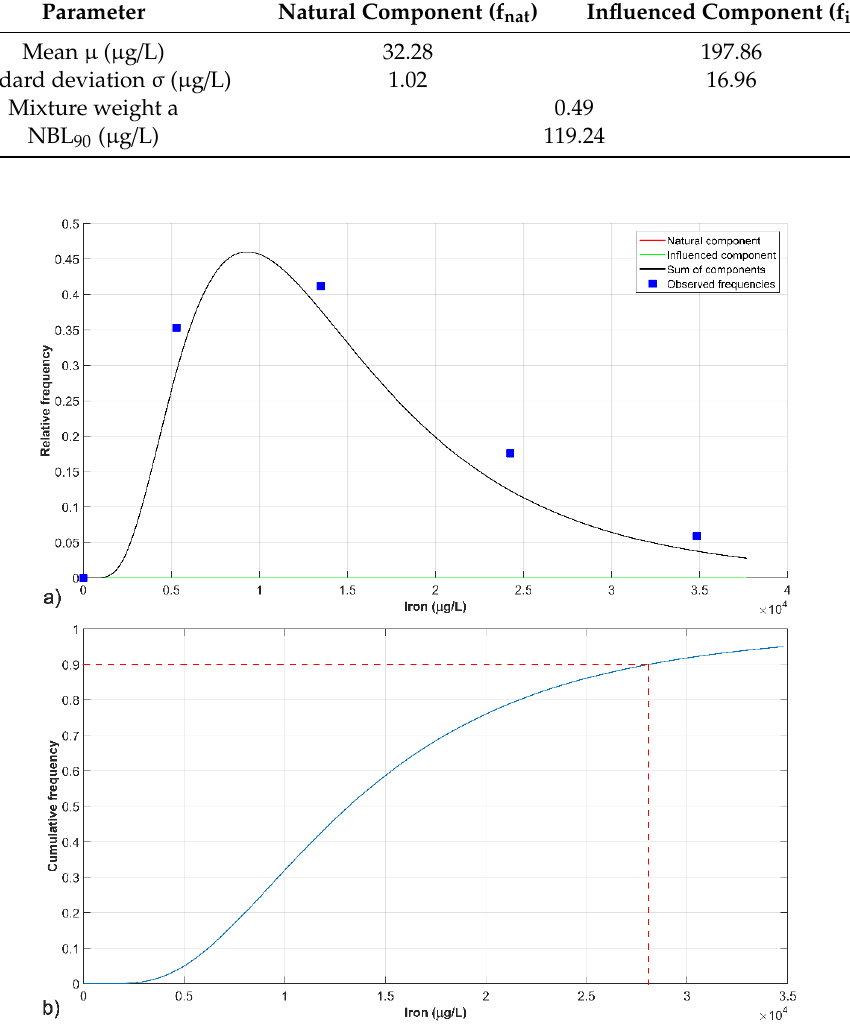
Figure 6. GuEstNBL output: ( a ) Iron empirical frequencies together with the estimated natural and anthropogenic components, and their weighted sum distribution; ( b ) CDF and 90th percentile of the identified log-normal PDF. Table 2. GuEstNBL output: Results of the guided estimation procedure for iron dataset.